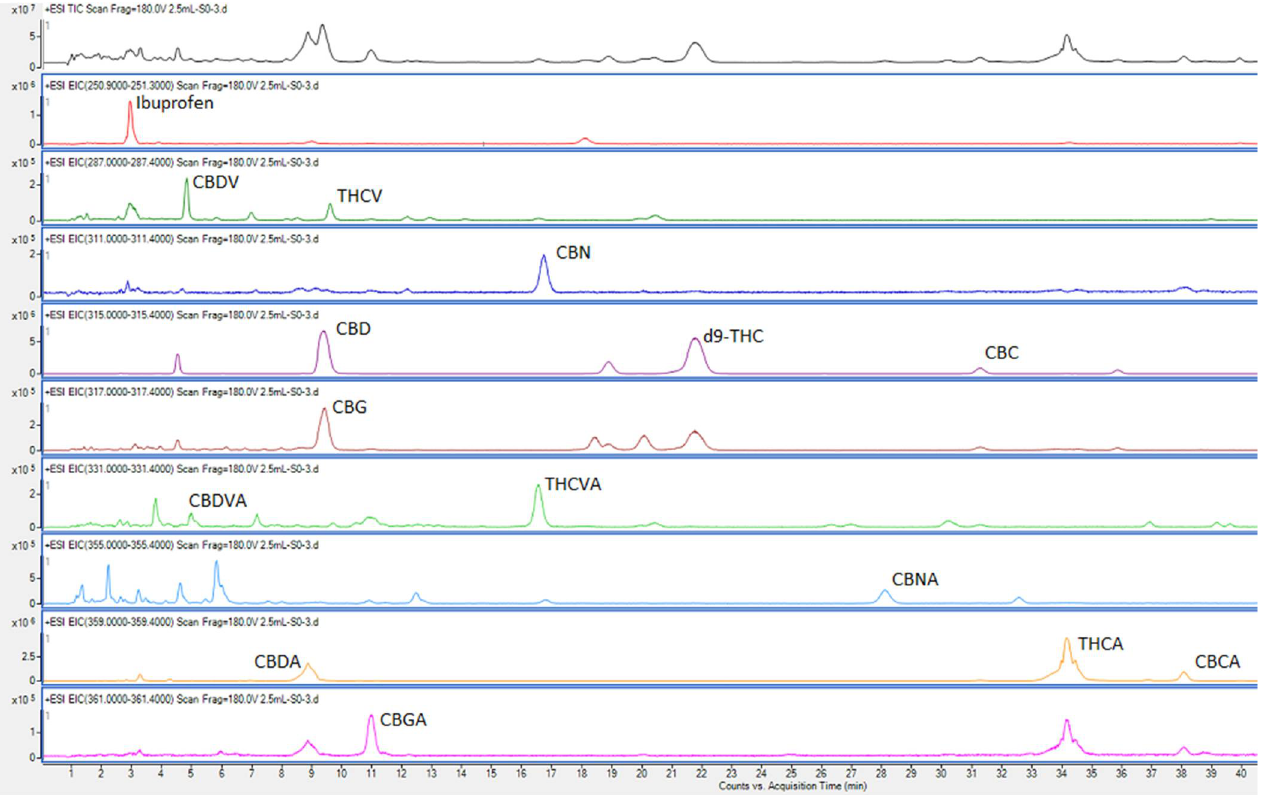
Figure 2. Chromatographic and mass spectrometric separation of Ibuprofen and cannabinoids in a pooled sample of cannabis inflorescence. Top Chromatogram shows the total ion chromatogram and the other chromatograms are extracted at the mass of compound/s. Table 4. Concentration ranges ( µ g/g) of cannabinoids found in 2 high CBD and 3 high THC